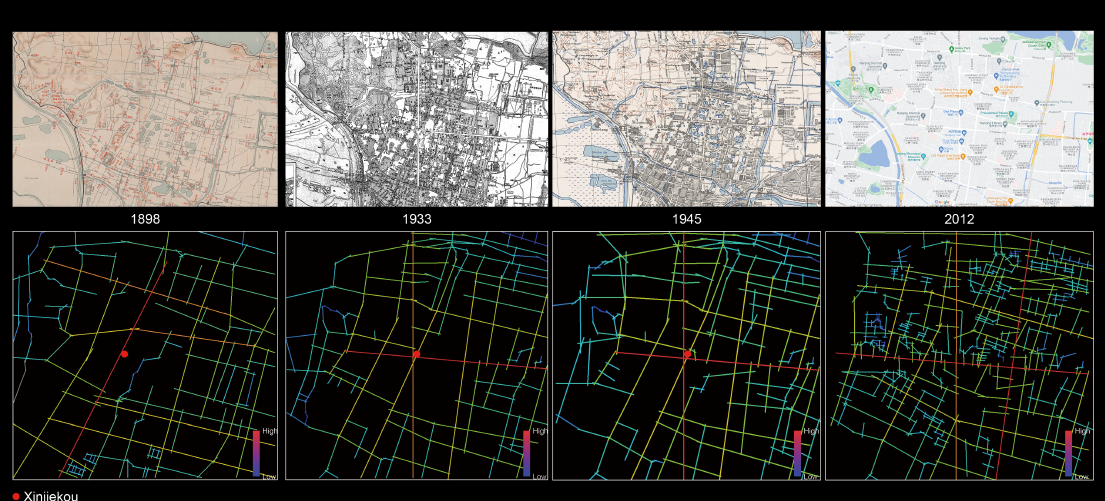
Figure 4. The evolution of the spatial structure of Xinjiekou on its spatial accessibility from 1898s to 2012s. (History map from http://dfz.nanjing.gov.cn/, accessed on 10 July 2022, digital map from https://www.google.com.hk/maps, accessed on 15 July